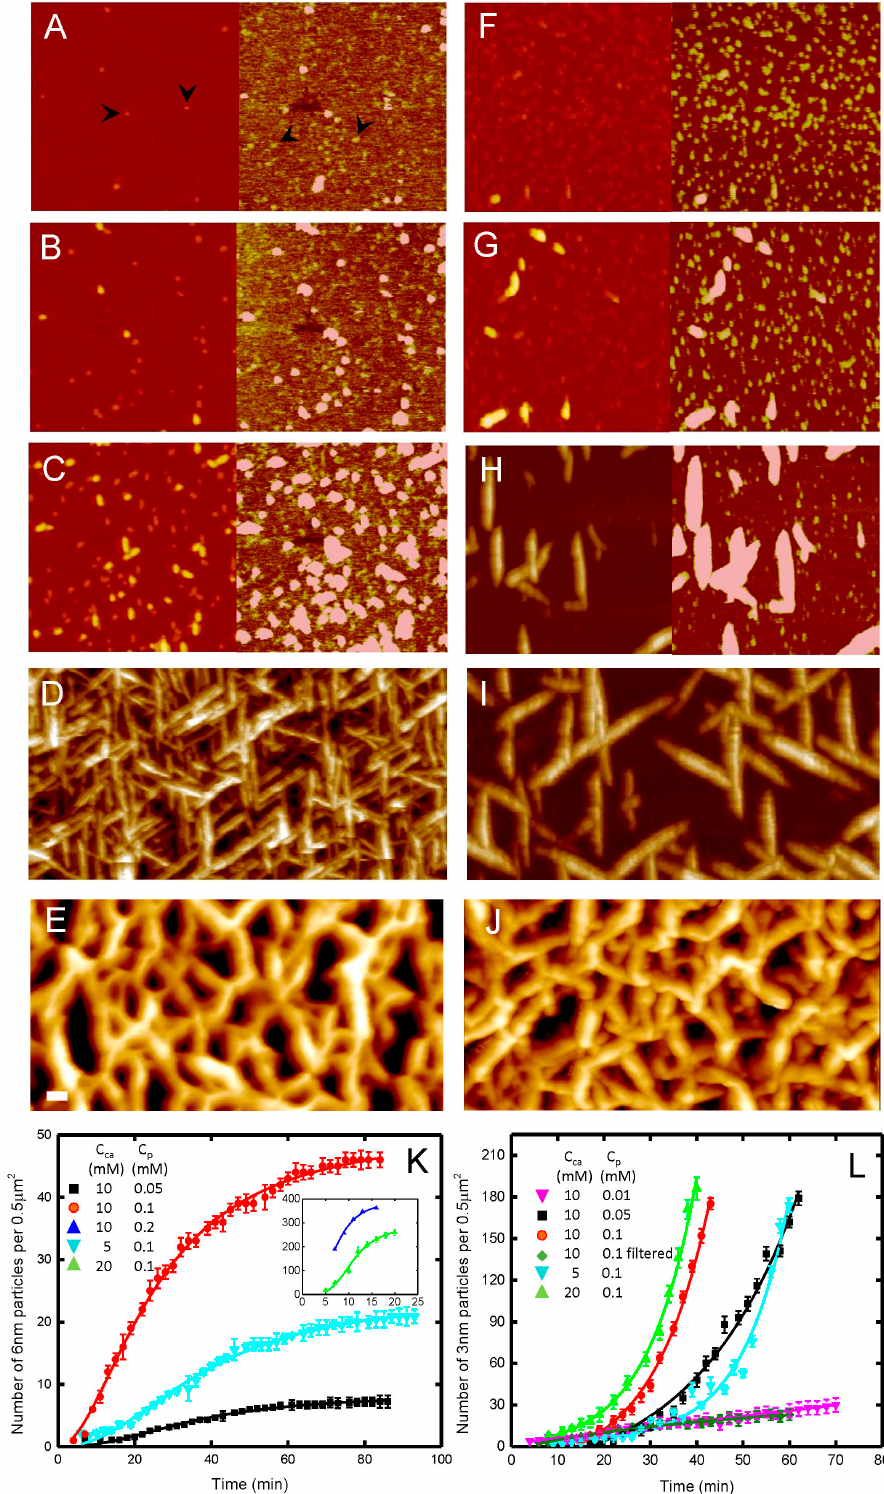
Figure 2. In situ view and kinetics of peptoid assembly. Nucleation and self-assembly of Pepc ( A – E ), and Pepb ( F – J ). ( A – D , F – I ): In situ AFM images showing assembly pathway of Pepc at t = 24.2 ( A ); 32.3 ( B ); 50.1 ( C ) and 275.1 ( D ) min; and Pepb at t = 4.3 ( F ); 17.2 ( G ); 69.1 ( H ); and 111.2 ( I ) min. ( E , J ): Ex situ AFM images showing self-assembled porous networks of Pepc ( E ) and Pepb ( J ). ( K , L ): Nuclei number density versus time for Pepc ( K ) and Pepb ( L ). Adapted from Ref. [31].